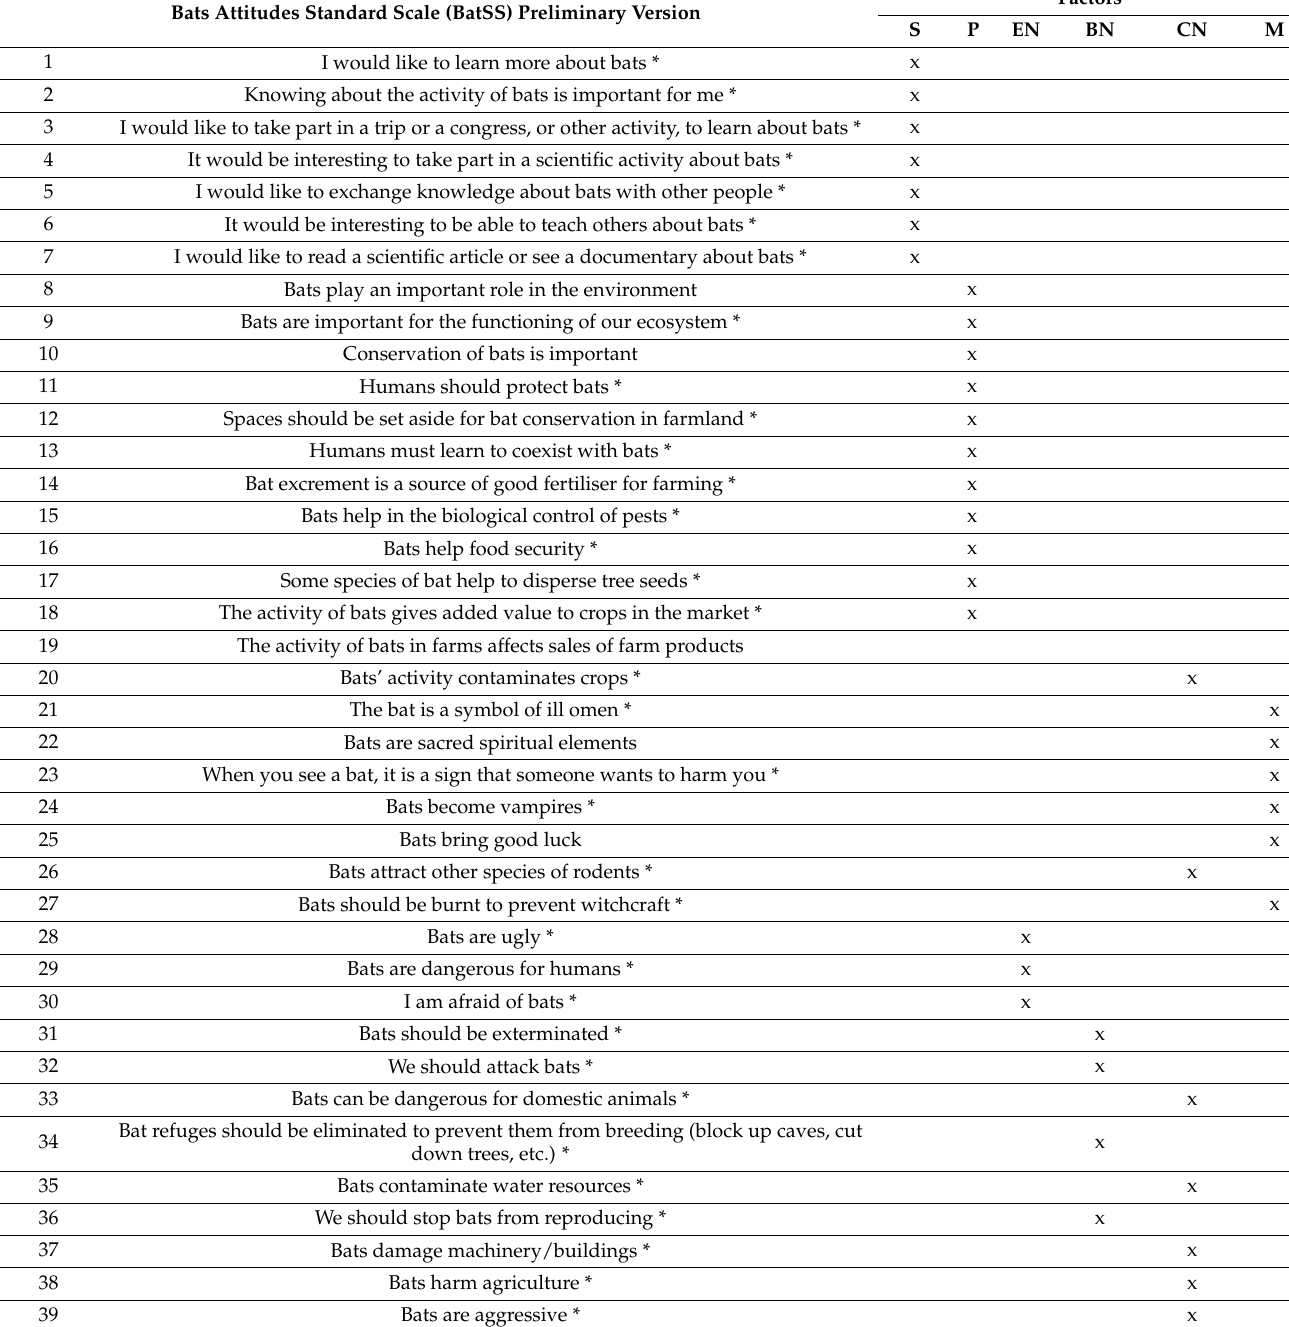
Table A1. Items of BatSS preliminary version, items removed in pilot study, and items eliminated in expert